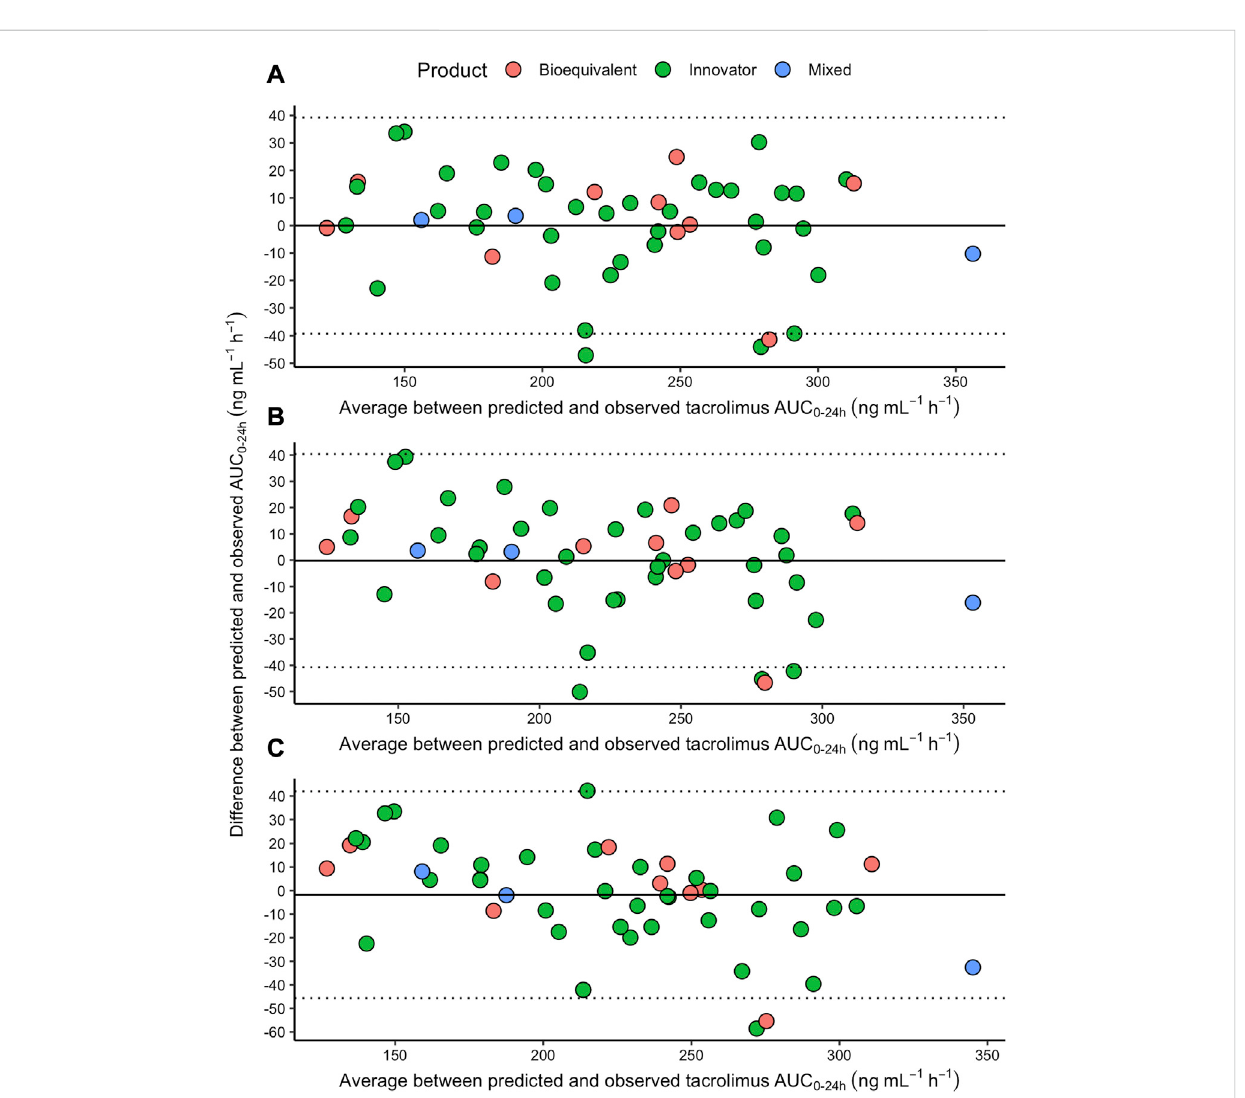
FIGURE 4 Bland-AltmanplottoanalyzetheagreementbetweeneachoneofthethreeLSS-predicted[ (A) =model12; (B) =modeldescribedbyAlmeida-Paulo using C 0 , C 1 and C 4 ; (C) = model described by Almeida-Paulo using C 0 , C 2 and C 4 ] and the observed trapezoidal AUC (0 – 24), with the innovator (green dots), the bioequivalent (pink dots) or a mixed combination (blue dots) of TAC extended-release products. The dotted lines represent the 95% upper and lower limits. The solid line represents the average of the arithmetic differences between the LSS-predicted and LSS-observed